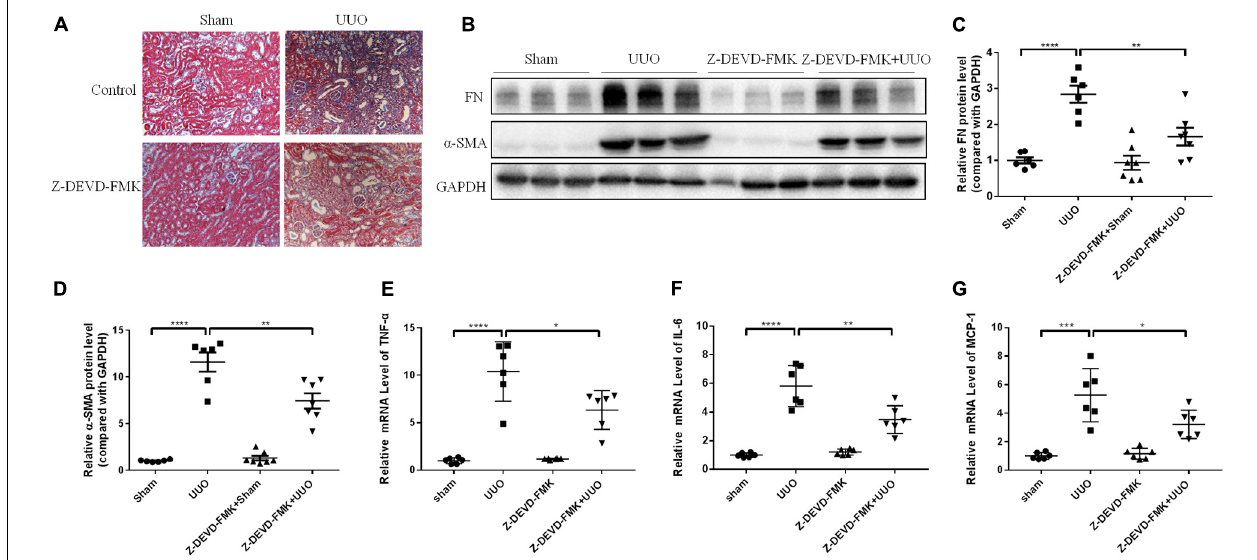
FIGURE 5 | Caspase-3 inhibitor alleviates renal fibrosis in UUO mice. Mice were intraperitoneally injected with Z-DEVD-FMK to identify the effect of caspase-3 inhibition in renal fibrosis. (A) Masson staining of kidney sections of UUO mice with Z-DEVD-FMK intraperitoneal injection (200 × ). (B–D) Western blotting analysis of FN and α -SMA in mouse kidneys from different groups ( n = 6–7). (E–G) qPCR analysis of tumor necrosis factor-alpha (TNF- α ), IL-6, and MCP-1 in mouse kidneys from different groups ( n = 6). All the quantitative results were shown as the means ± SEM. * p < 0.05; ** p < 0.01; *** p < 0.001; **** p <